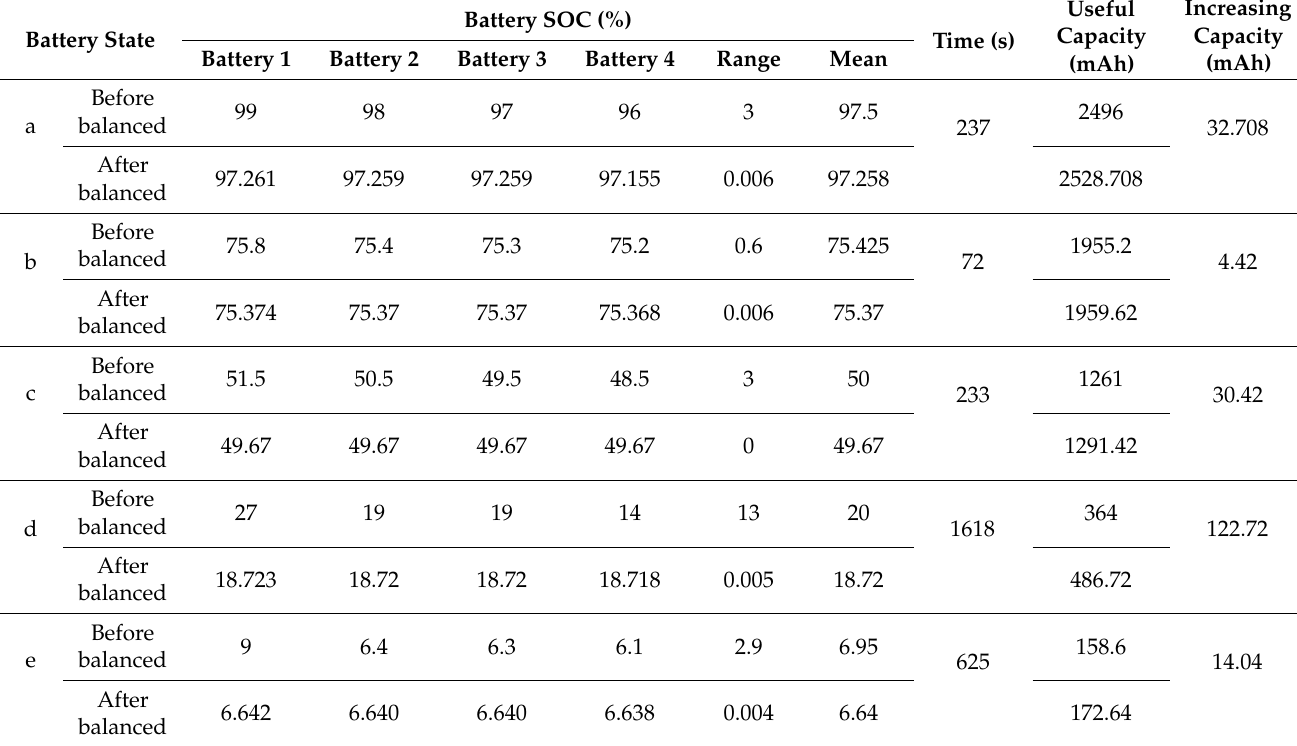
Table 3. Battery balance results under different